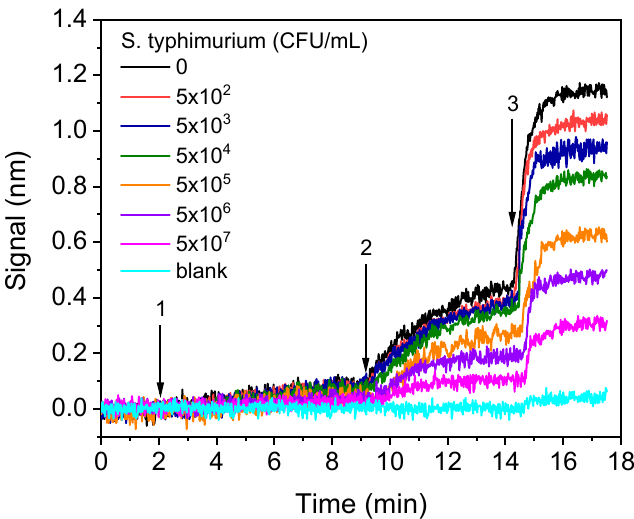
Figure 7. Real-time sensor responses corresponding to S. typhimurium bacteria calibrators with concentrations from 5 × 10 2 to 5 × 10 7 CFU/mL prepared in assay buffer. The arrows indicate the sequence of solutions running over the chip: assay buffer, start to arrow 1; mixture of calibrators with anti- Salmonella antibody, arrow 1–2; biotinylated anti-rabbit IgG antibody, arrow 2–3; streptavidin.